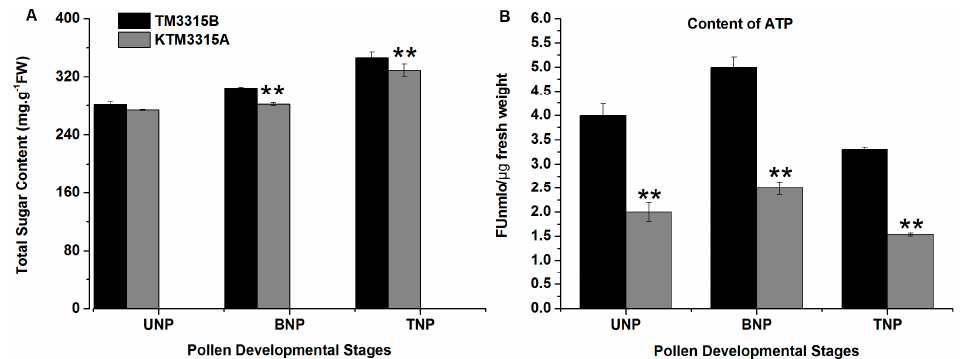
Figure 8. ATP and total soluble sugar contents of anthers. ( A ) Total soluble sugar contents of anthers from the maintainer line (TM3315B) and sterile line (KTM3315A) during different developmental stages. ( B ) ATP content of anthers from the uninucleate (UNP) to trinucleate stages (TNP). Data represent the mean and standard deviation based on three replicates. ** p < 0.01 according to the Student’s t -test.